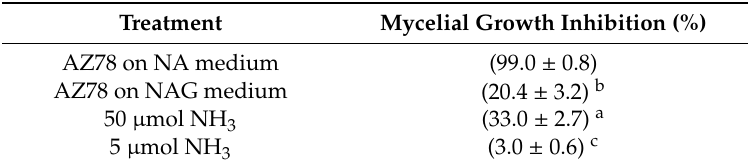
Table 2. Involvement of gaseous ammonia produced by Lysobacter capsici AZ78 in Rhizoctonia solani growth